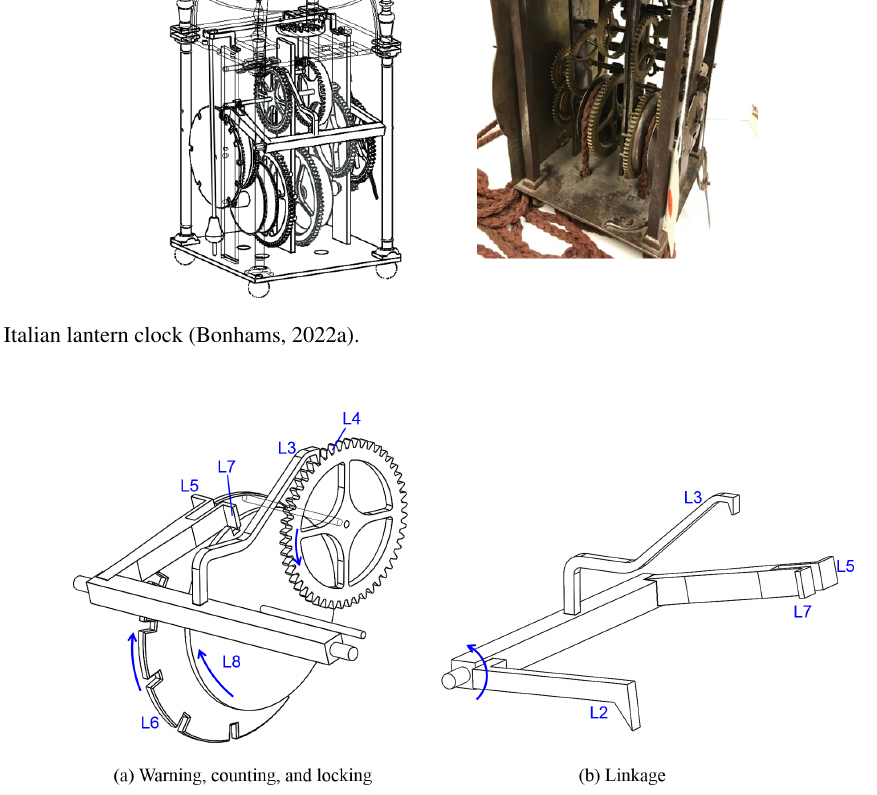
Figure 31. Structure and operation of the N12 trigger mechanism. (The trigger is similar to that of N5.)